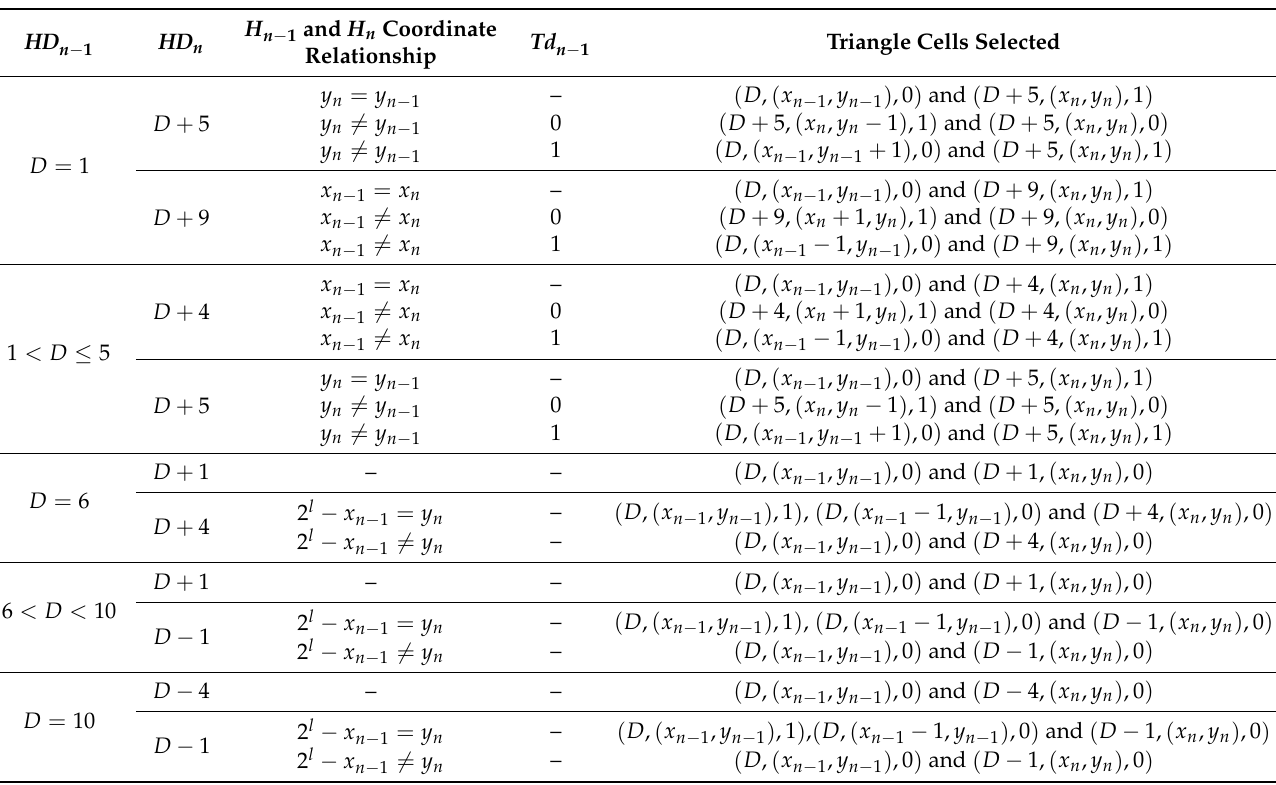
Table 8. Htotcode rule of the ( n − 1)th hexagon cell C 1